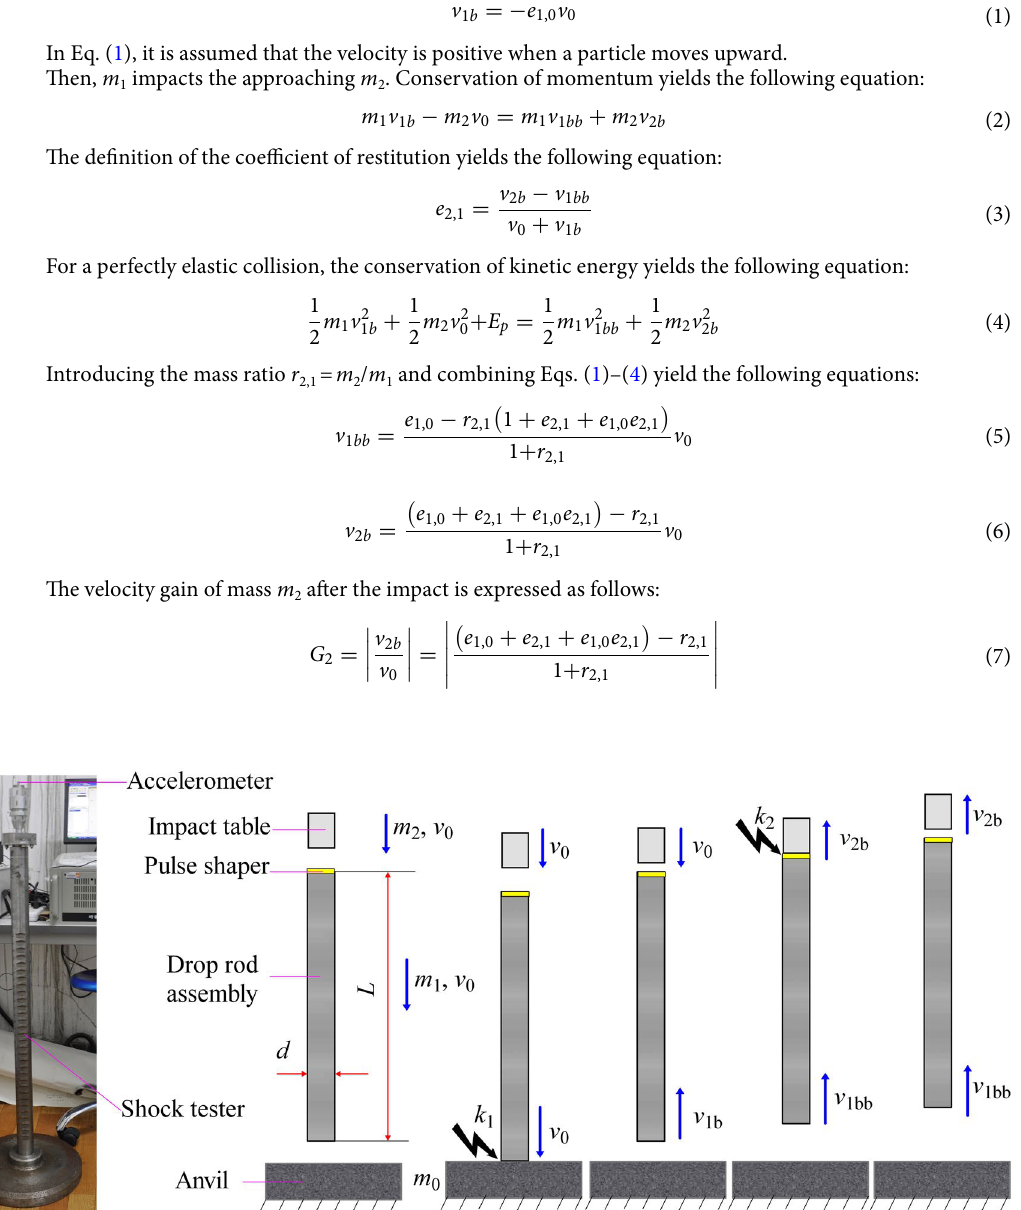
Figure 1. High- g shock tester and model of a one-dimensional three-body collision ( m 0 > m 1 > m 2 ). m 1 , L , and v 0 represent the mass, length, and initial velocity of the drop rod assembly, respectively, m 2 and v 0 are the mass and initial velocity of the impact table, respectively, and m 0 is the mass of the anvil. The diameters of m 1 and m 2 are both d , v 1b is the rebound velocity of m 1 after striking m 0 , k 1 and k 2 are the stiffness coefficients of equivalent impact springs when m 1 strikes m 0 and m 2 collides with m 1 , respectively, and v 1bb and v 2b are the velocities of m 1 and m 2 after m 2 collides with m 1 ,